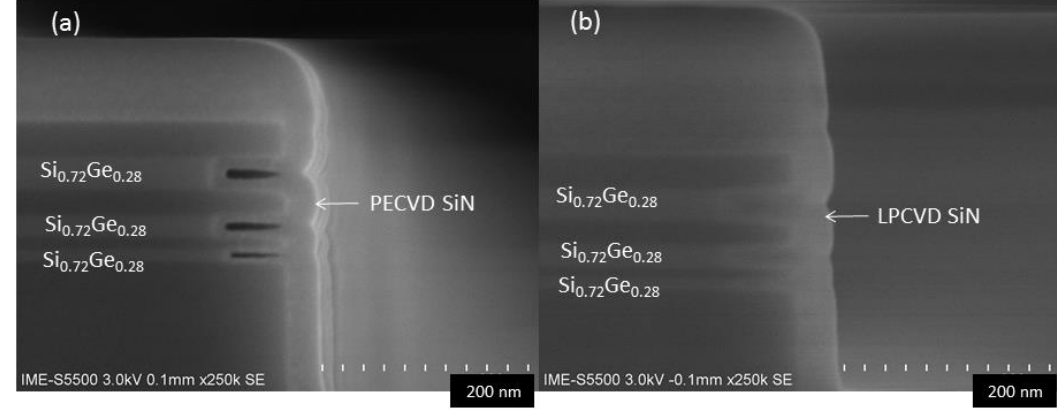
Figure 4. SEM images of the SiN inner spacer filling by using: ( a ) plasma enhanced chemical vapor deposition (PECVD) and ( b ) low-pressure chemical vapor deposition (LPCVD). deposition (PECVD) and ( b ) low-pressure chemical vapor deposition